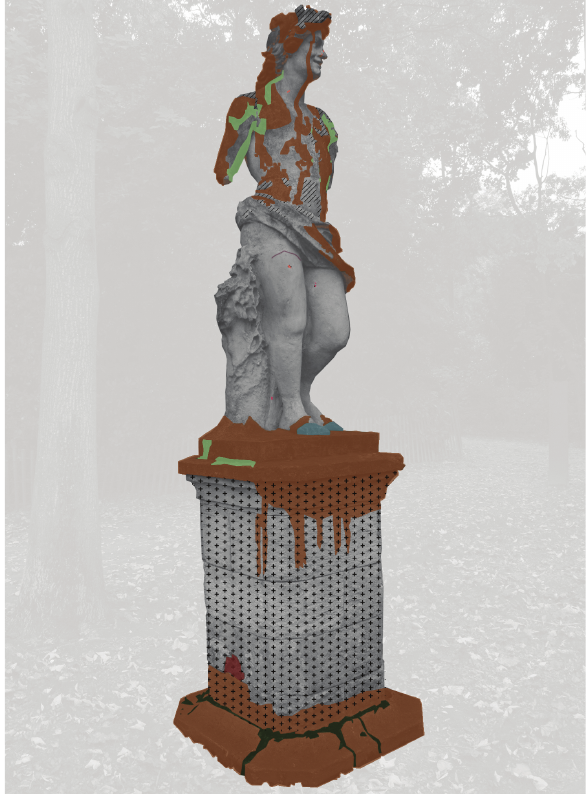
Figure 5. Alterations in 2011